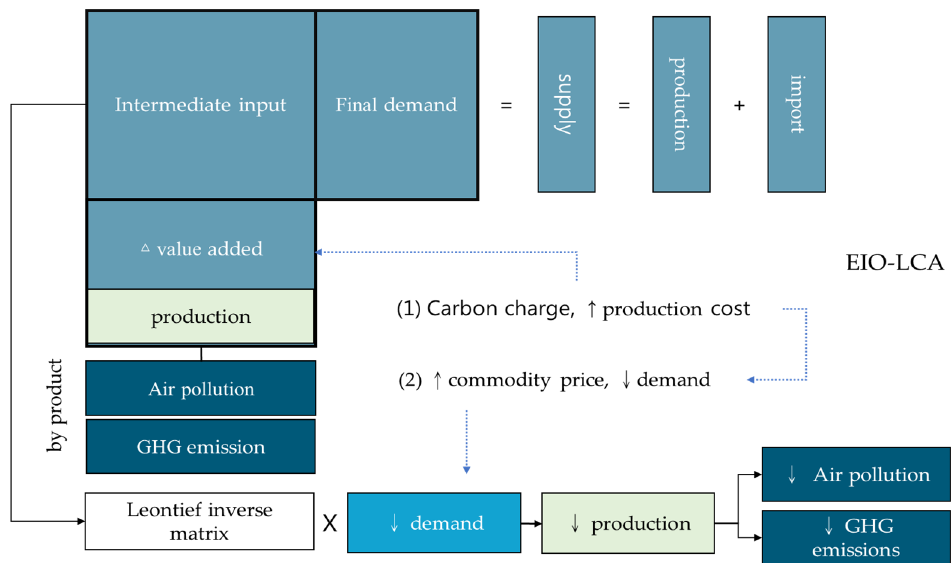
Figure 2. Conceptual framework of the Taiwan EIO-LCA model.